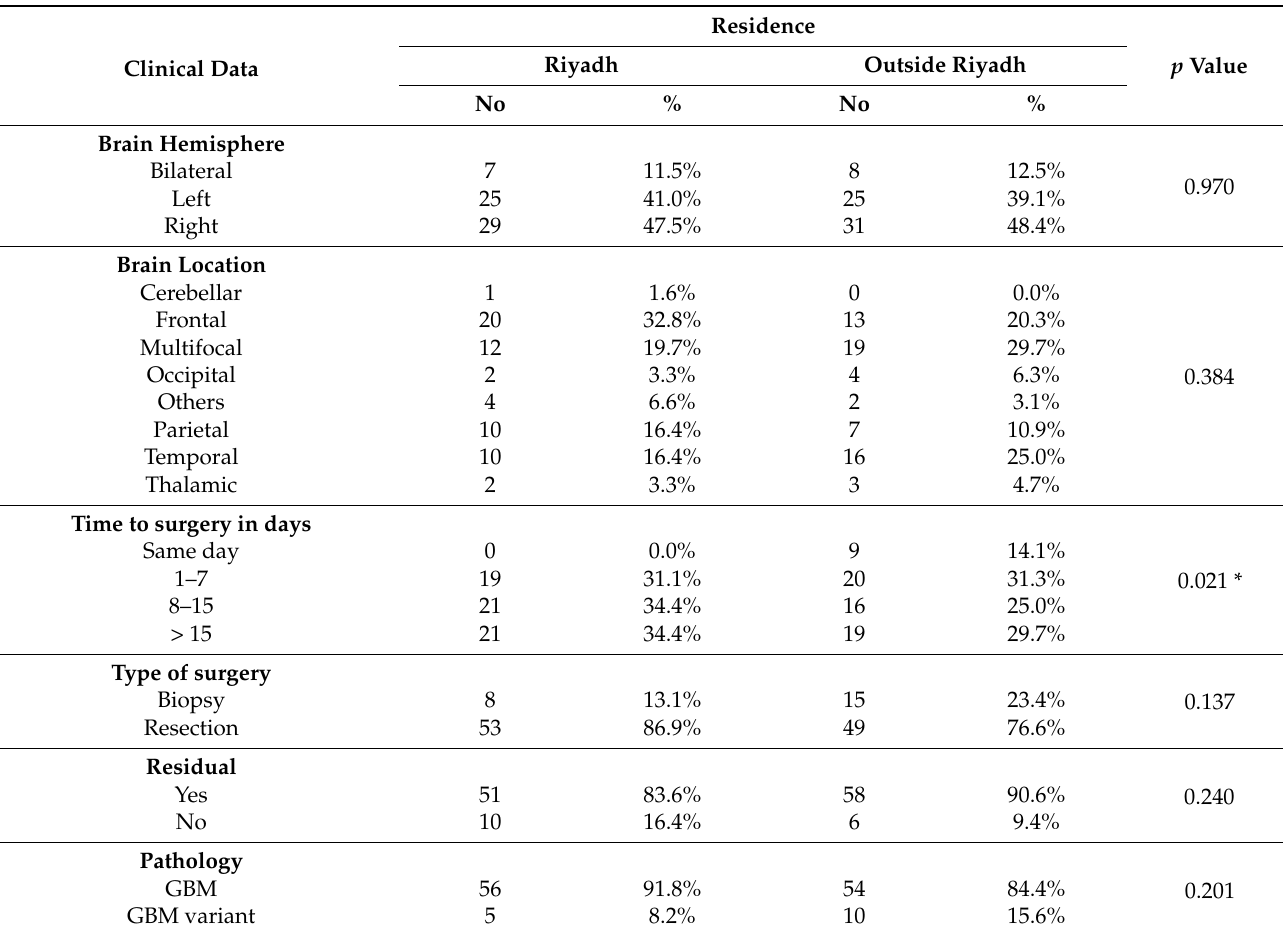
Table 2. Distribution of study sample clinical data by residence.